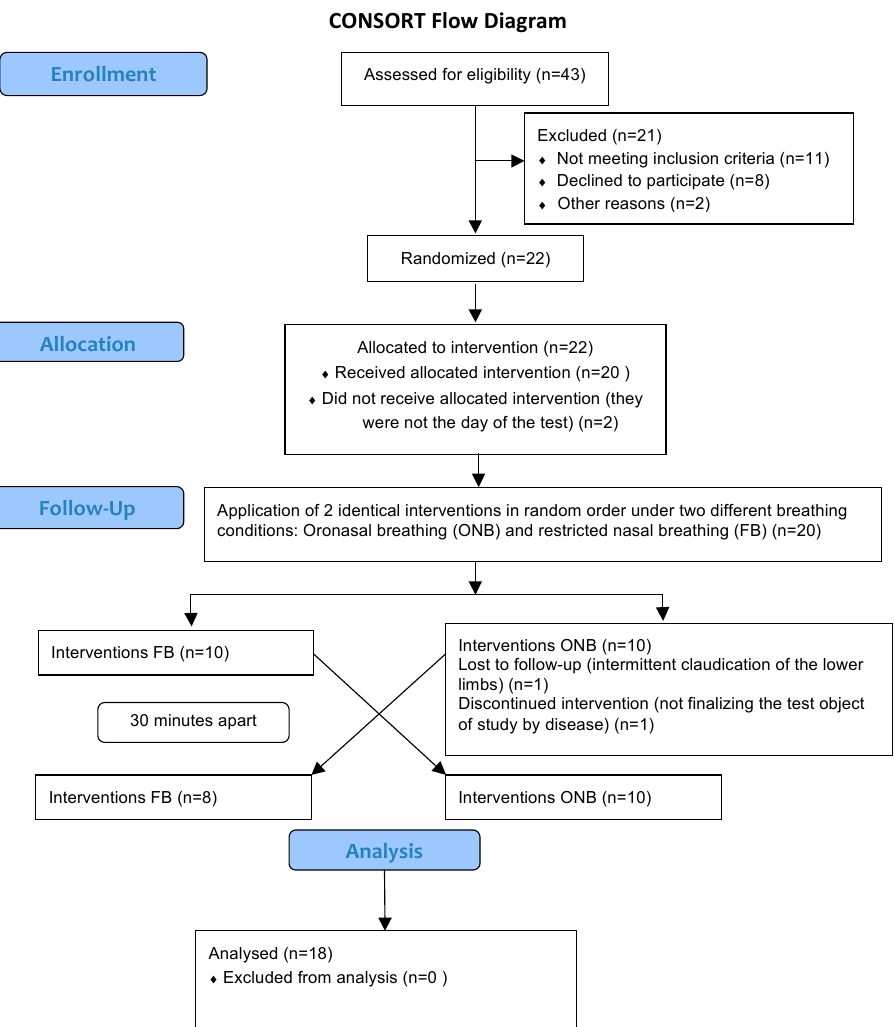
Figure 1. Illustration of the design and analysis of the cross-over trial.